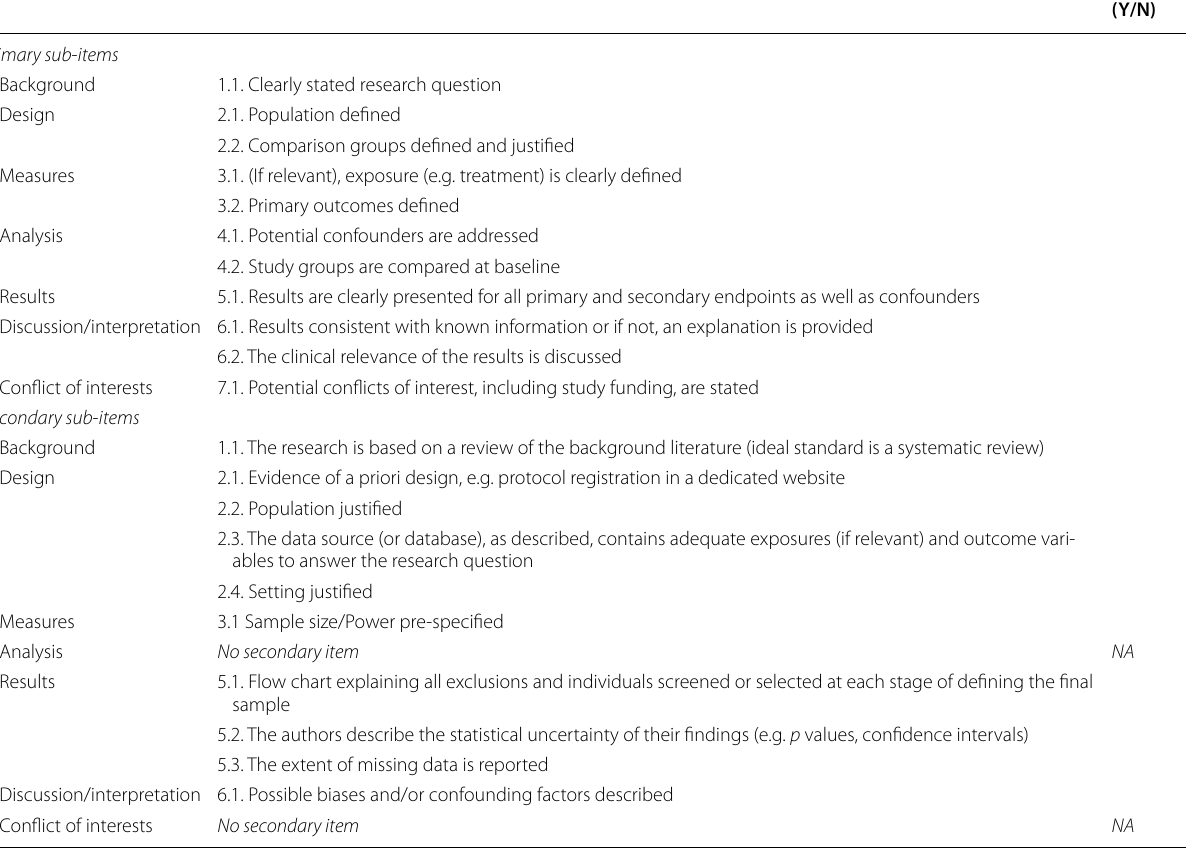
Table 3 RELEVANT quality domains: primary sub-items (critical to satisfy minimum guideline requirements) and secondary sub-items (enabling further descriptive appraisal) Quality domains and